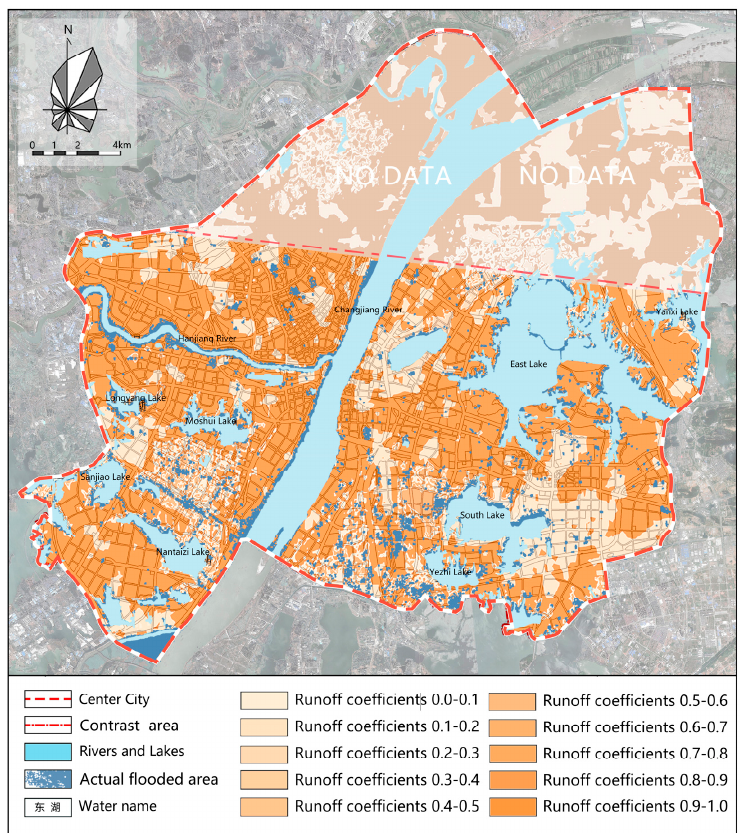
Figure 15. Spatial characteristics of the flood-submerged areas in south downtown Wuhan based on the model.